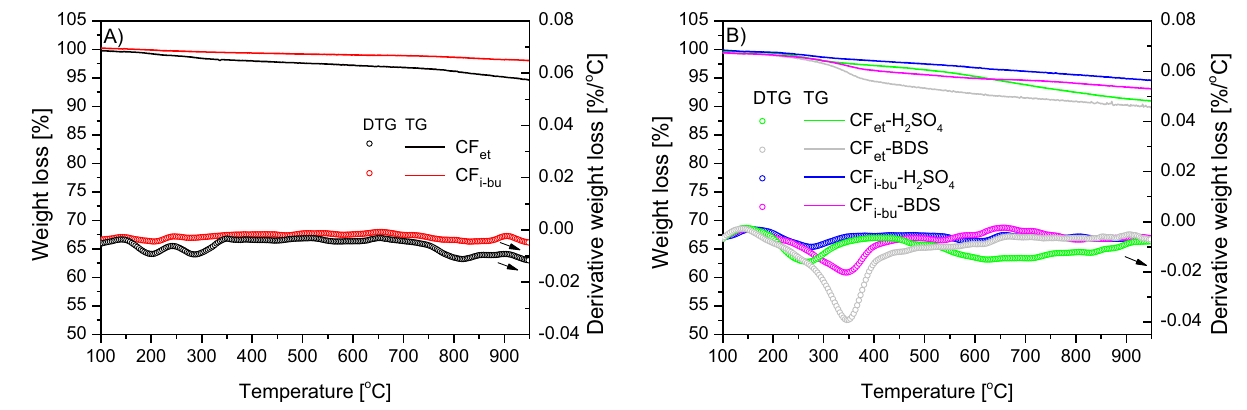
Figure 6. TG and DTG curves of the parent samples ( A ) and the modified CFs ( B ) for the analyses performed in nitrogen flow.